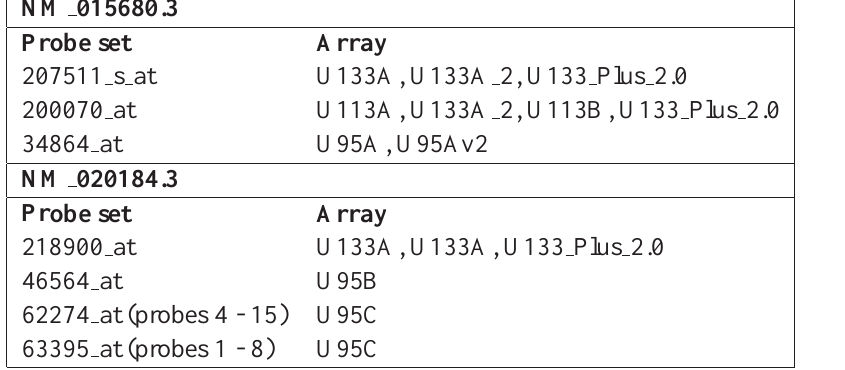
Table 1: Probe sets and corresponding human Affymetrix GeneChips mapping to NM 015680.3 and NM